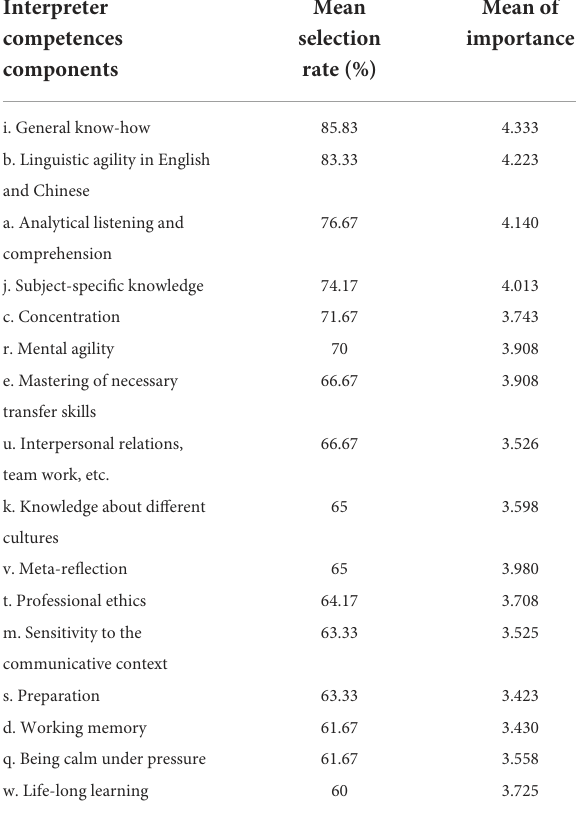
TABLE 11 Frequently selected components participants felt still inadequate in that impeded development of career